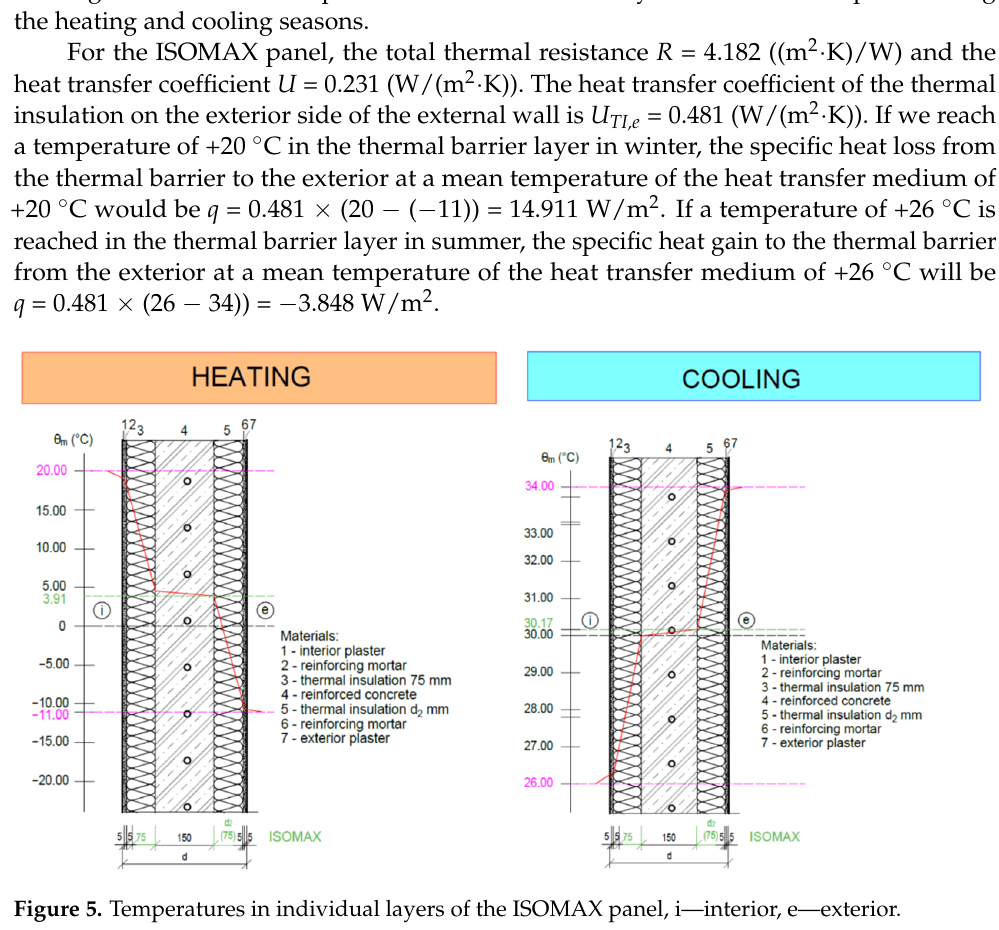
Table 2. Results of calculation of physical quantities during the cooling season.